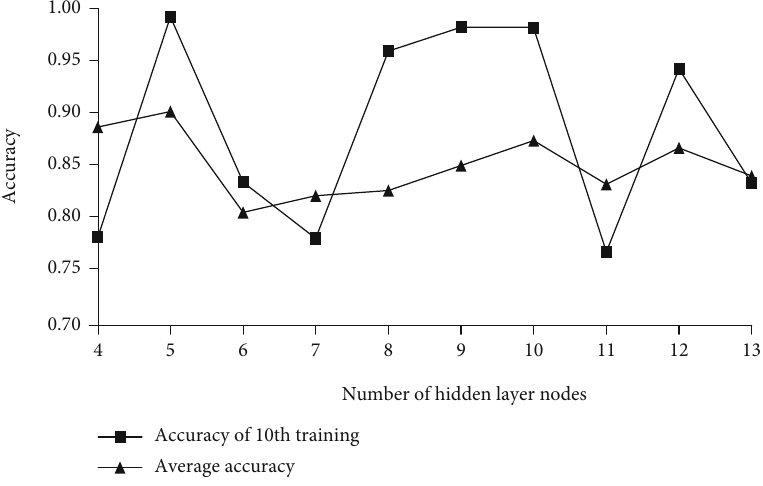
Figure 3: Prediction accuracy of nodes in di ff erent hidden layers. Table 2: Accuracy of di ff erent fi tness functions.